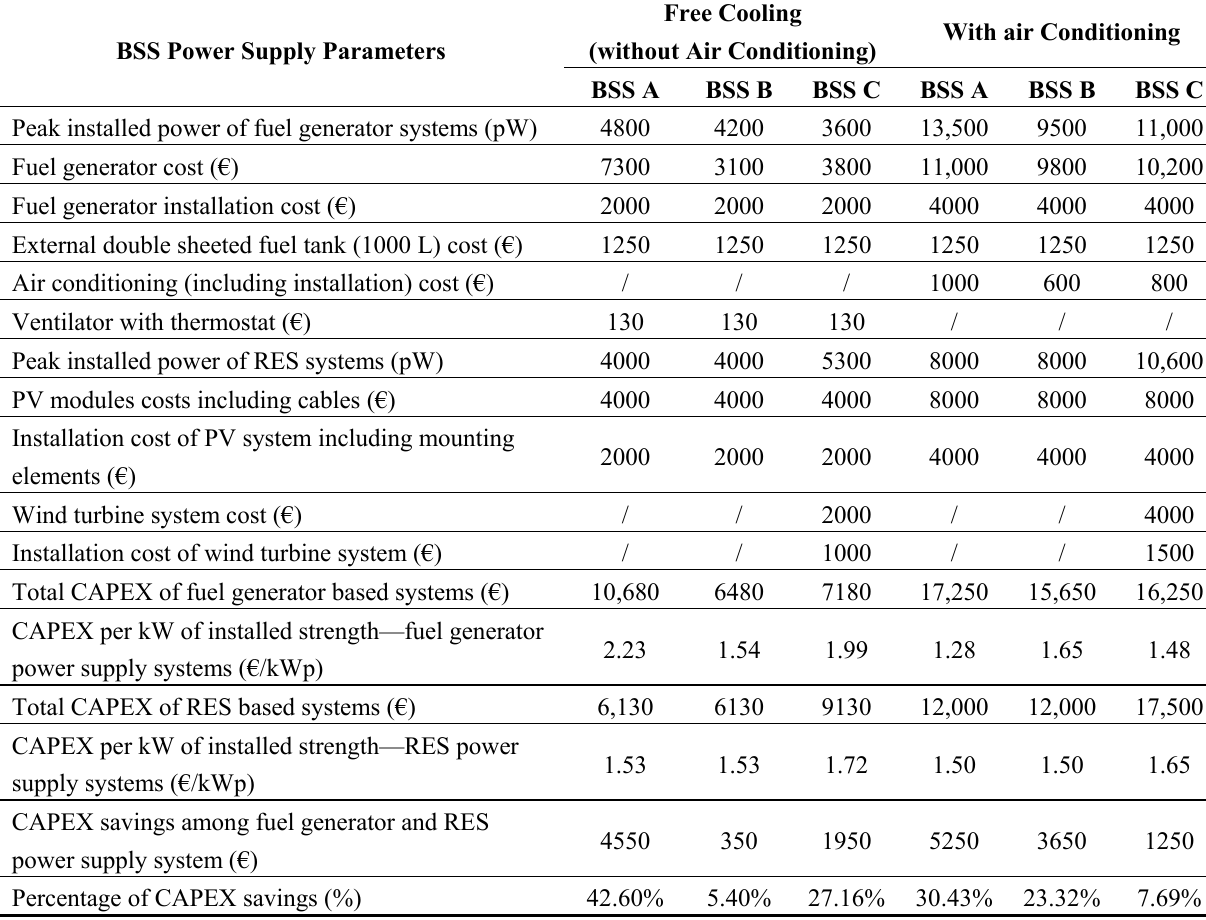
Table 6. Capital expenditure (CAPEX) comparison among the BSSs power supply systems with respect to the different temperature regulation